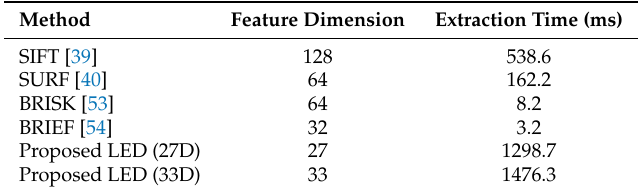
Table 9. Comparison of feature description time of different